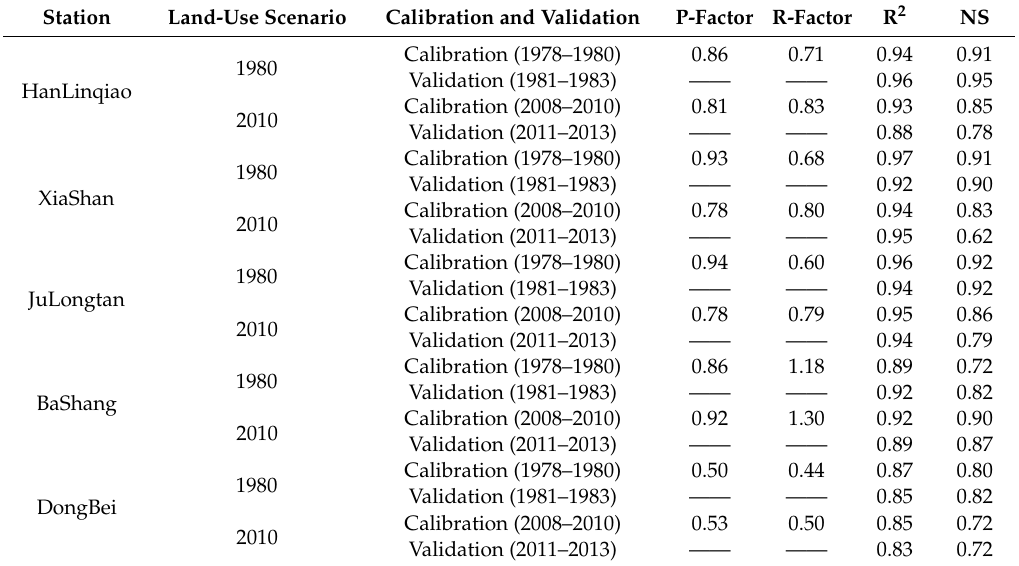
Table 2. Results of uncertainty analyses and evaluations of the simulations under two historical scenarios, 1980 and 2010, at each hydrological